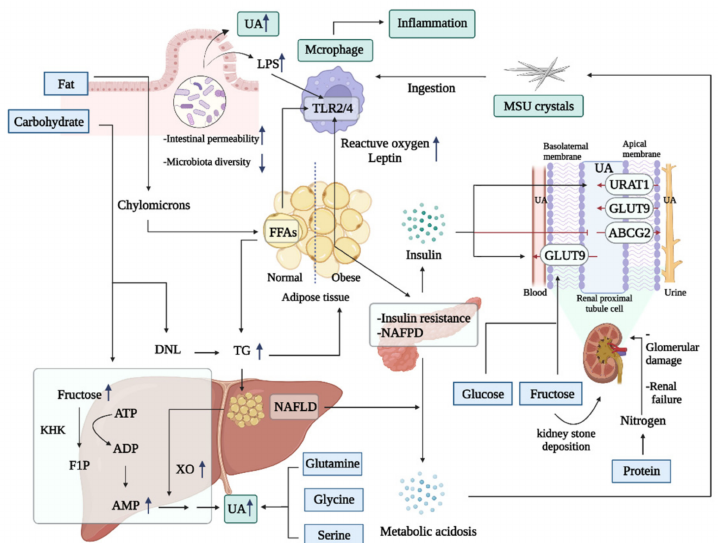
Figure 2. Nutrition-induced systemic metabolism involved in gouty disease. Metabolites of fat, carbohydrate and protein and the resulting metabolic diseases promote the development of gout, including changing intestinal flora, accelerating purine metabolism, promoting MSU deposition, activating macrophages, and inhibiting uric acid excretion. ADP, adenosine diphosphate. AMP, adenosine monophosphate. ATP, adenosine triphosphate. FFAs, free fatty acids. F6P, fructose 6 phosphate. KHK, ketohexokinase. LPS, lipopolysaccharide. MSU, monosodium urate. NAFLD, nonalcoholic fatty liver disease. NAFPD, nonalcoholic fatty pancreas disease. TG, triglyceride. TLR, toll-like receptor. UA, uric acid. XO, xanthine